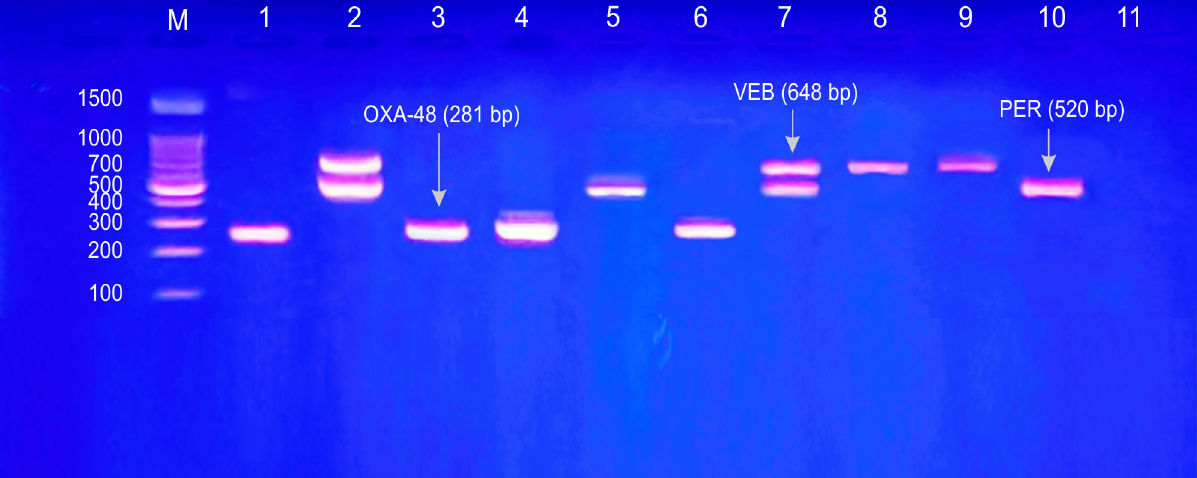
Fig 1. Gel electrophoresis of PCR amplified products for detection of carbapenemases genes: Multiplex I & II. Multiplex I & II: bla GES (399 bp), bla PER (520 bp), bla VEB (648 bp) and bla OXA-48 (281 bp). Lane m: DNA Ladder (100 pb); Lanes 1, 3, 4 and 6: positive results for bla OXA-48 ; Lanes 2 and 7: positive results for bla VEB and bla PER ; Lanes 5 and 10: positive results for bla PER ; Lanes 8 and 9: positive results for bla VEB ; Lane 11: negative results for all genes.